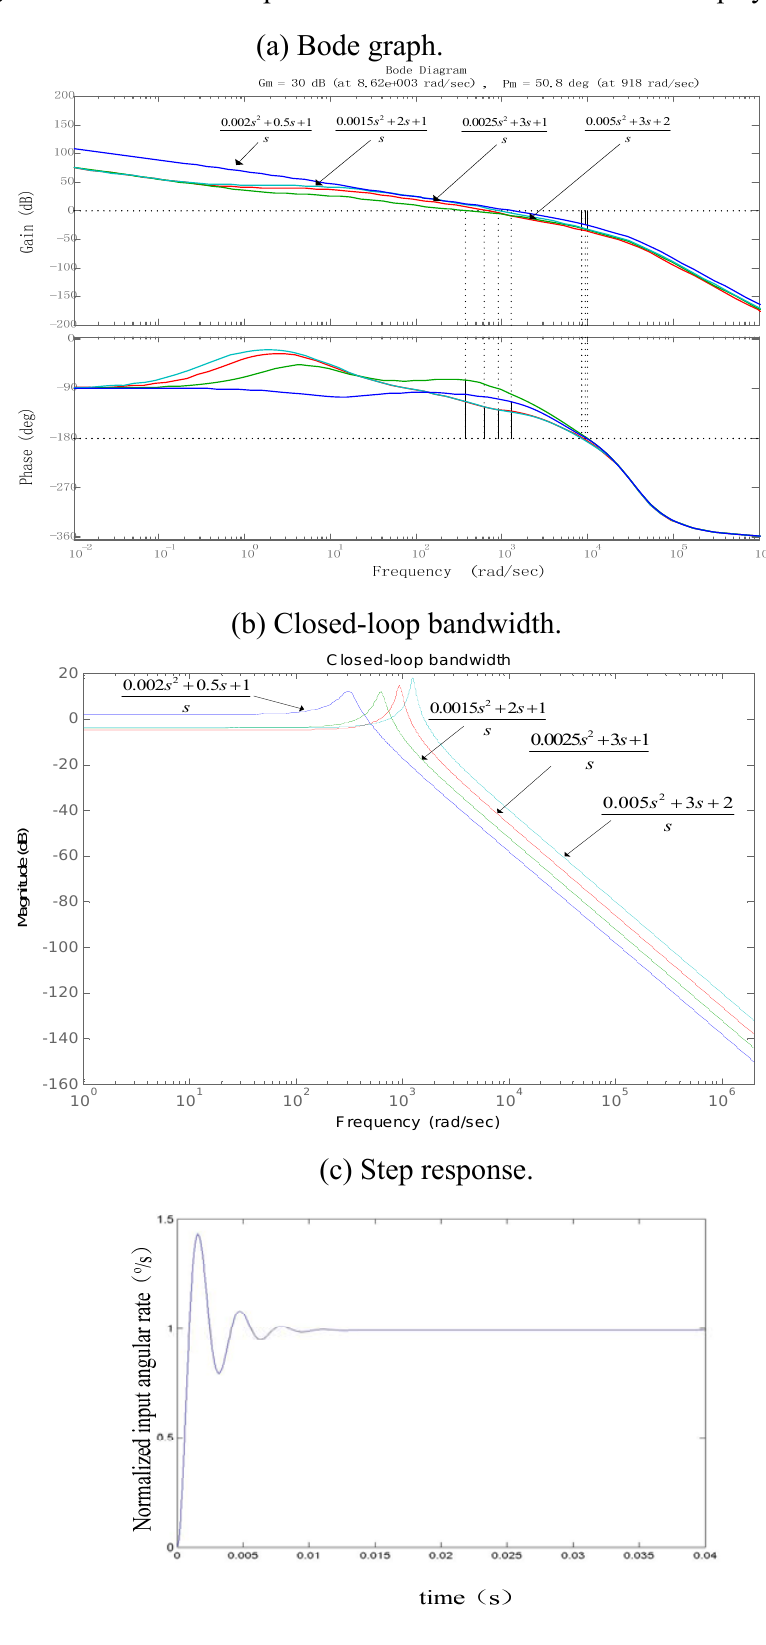
Figure 7. The simulated performances of the whole closed-loop